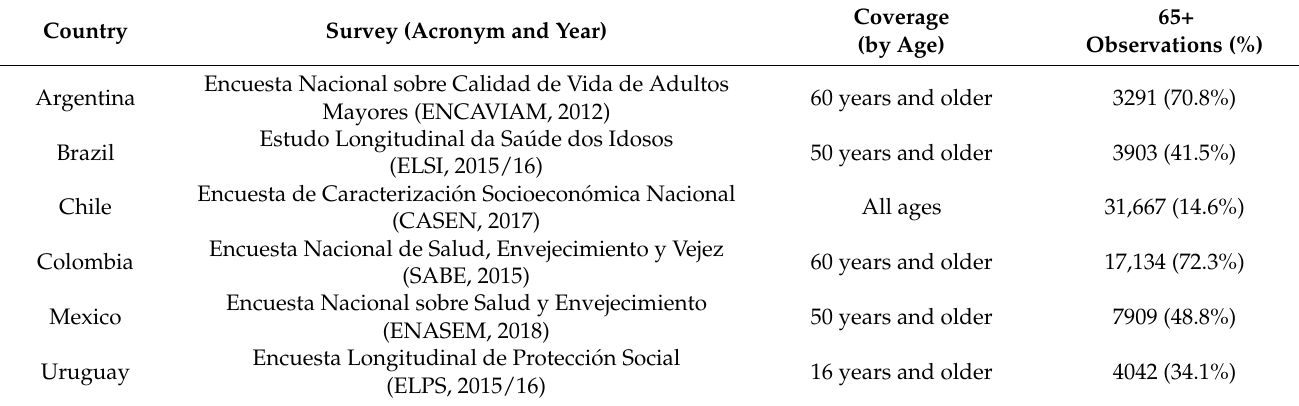
Table 2. Description of the sources, country, name, year, coverage, and sample of adults 65 and older (Obs. and % sample) + . Country